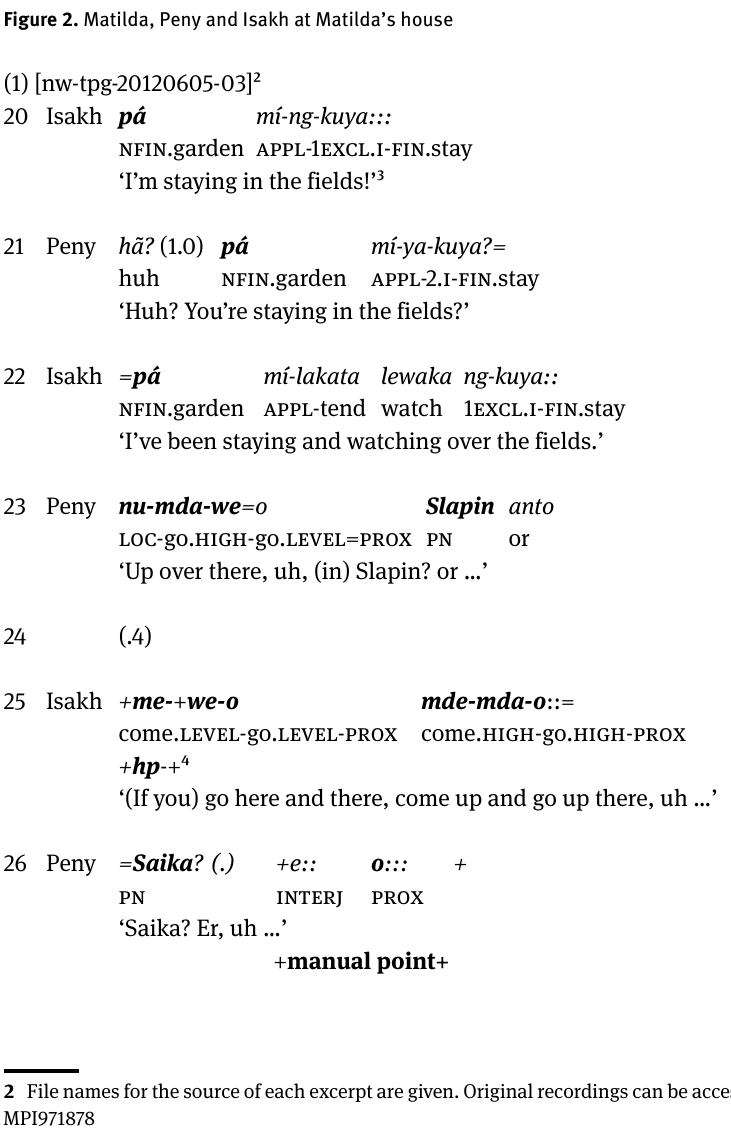
Figure 2. Matilda, Peny and Isakh at Matilda’s